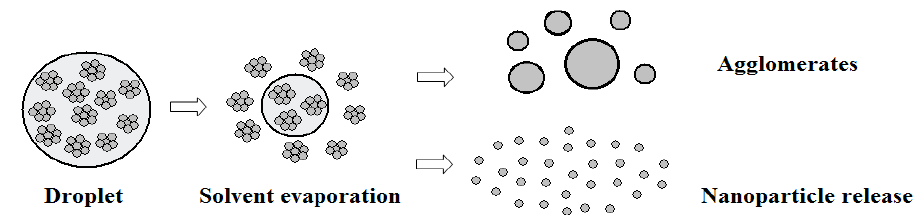
Figure 4. Schematic of droplet injection, solvent evaporation and nanoparticle release. Reproduced with permission from [17]. Copyright Courtesy of Delbos,